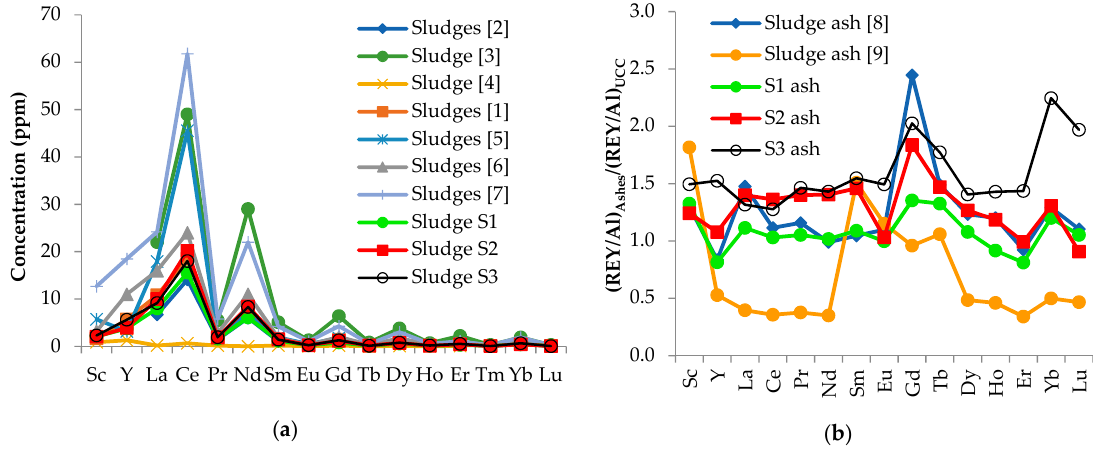
Figure 1. REY in the sludges and their ashes: ( a ) Concentrations in the sludges; ( b ) Enrichment factors relative to Al (EFs) of sludge